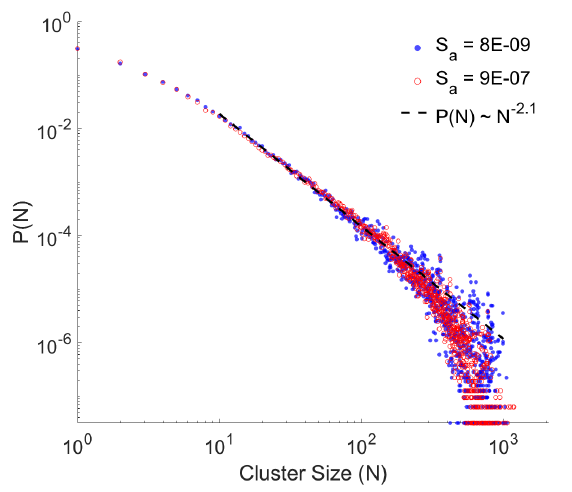
Figure 3. The distribution of fragile cluster sizes at two shear rates separated by order of magnitude. S a refers to Savage num- ber.